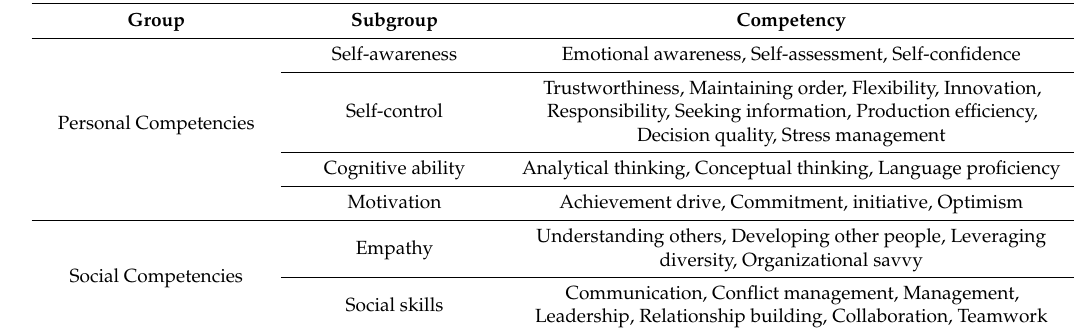
Table 2. Categorization of project managers’ competencies in Cycloid.